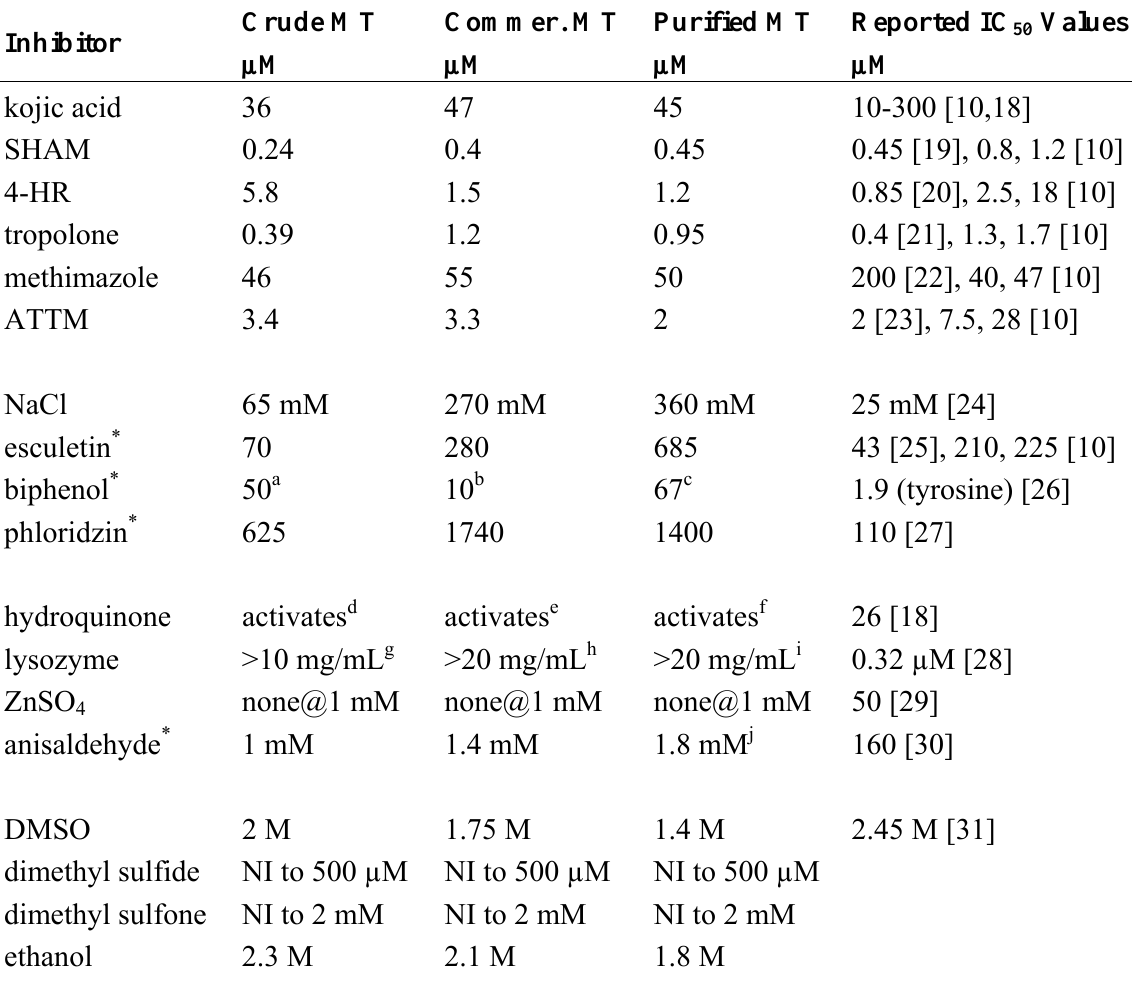
Table 1. IC values for mushroom tyrosinase 50